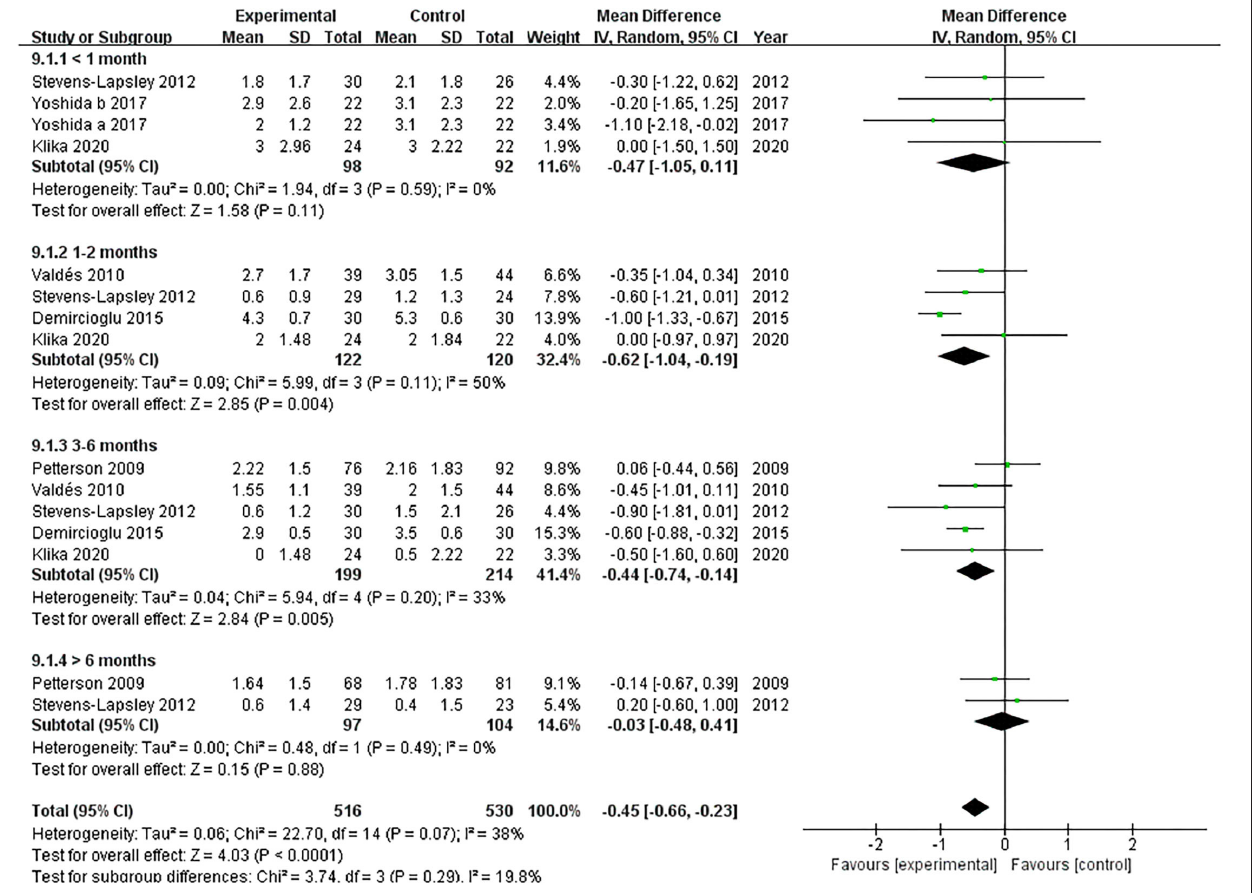
Frontiers in Medicine |